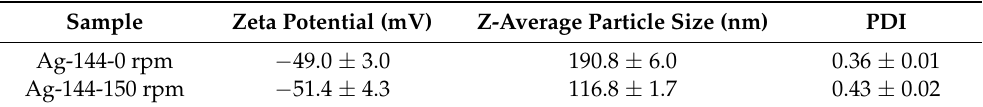
Figure 10. Size distribution for the samples ( a ) Ag-72-150 rpm, ( b ) Ag-72-0 rpm, ( c ) Ag-144-150 rpm and ( d ) Ag-144-0 rpm. Table 3. DLS data for the AgNPs obtained under static and dynamic conditions.